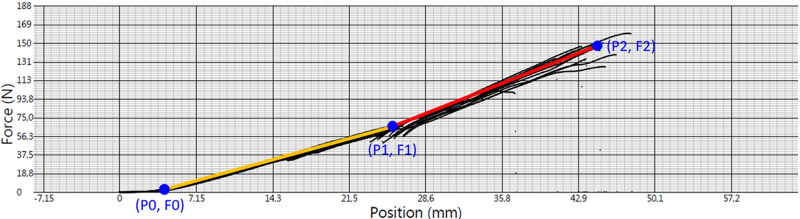
Elasticity: Estimation of k1 and k2 from force–displacement curve.F is the applied force and P is the displacement (amount of elongation).